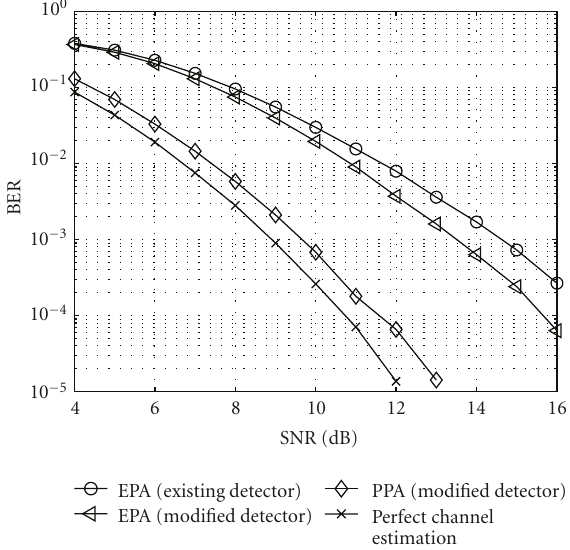
Figure 2: BER performance of di ff erent power allocation schemes (QPSK).